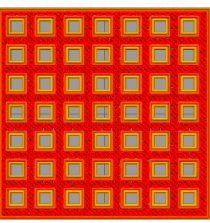
Figure 2. The geometry of samples. Table 1. Characteristics of polylactic acid (PLA) printing materials.